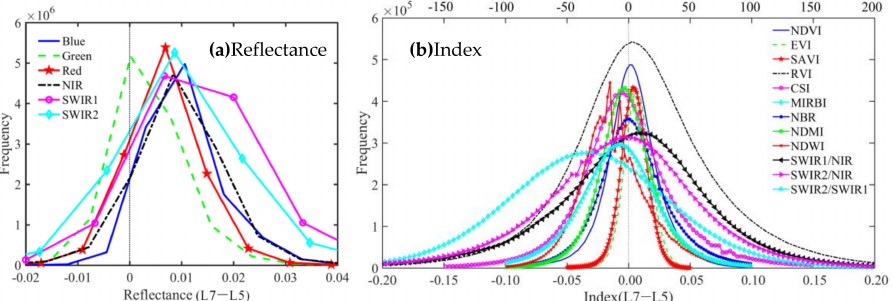
Figure 9. Difference histograms between forward and backward spectral reflectance ( a ) and indices ( b ) of the overlapped TM/ETM+ images from 2001. The MIRBI value is denoted at the upper X-axis, and the lower X-axis for other